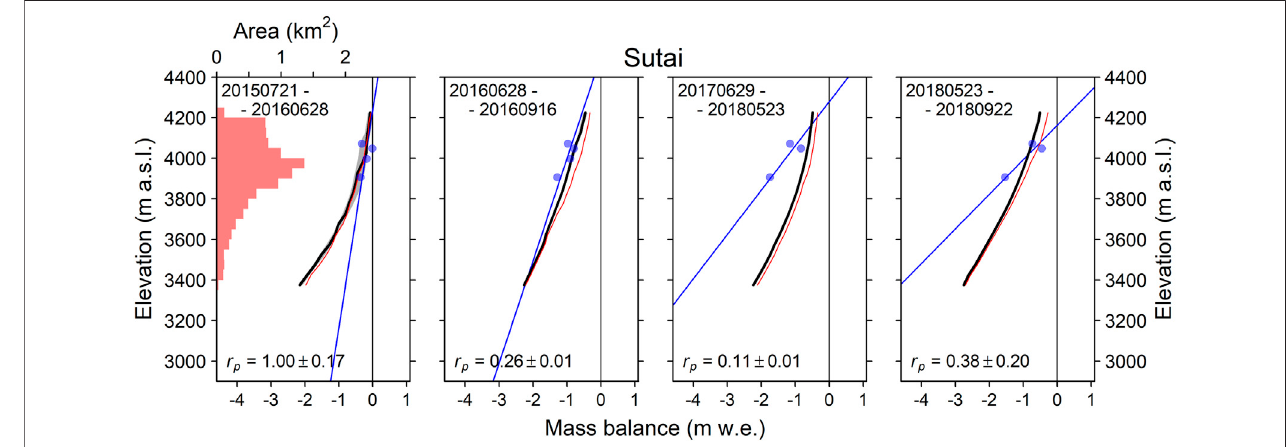
FIGURE 4 | As Figure 3 , but for Sutai Glacier.